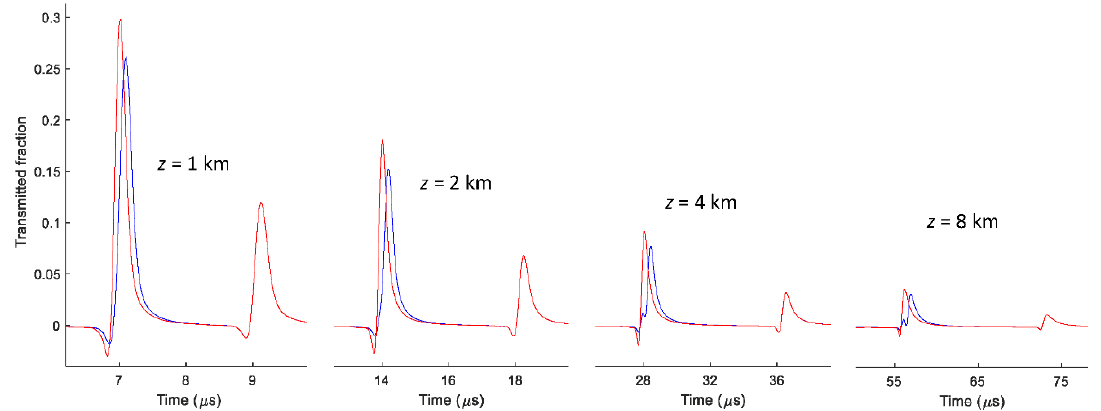
Figure 7. Time-domain waveforms as function of traveled distance z ; red curves correspond to signal injection in the phase conductor with higher temperature, the blue curves correspond to injection in one of the other phase conductors.